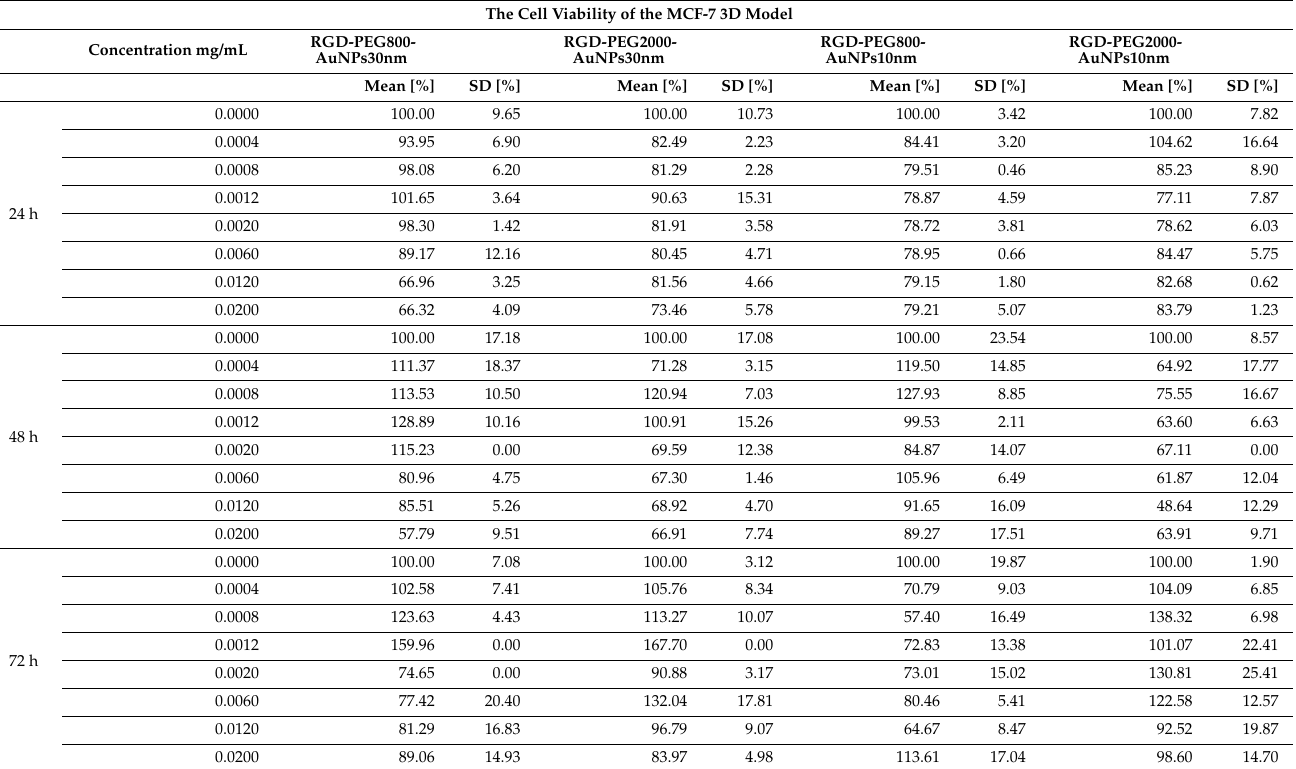
Table 2. The resume of the viability level of the MCF-7 3D model after incubation with AuNPs. In this test, RGD-PEG 800 -AuNPs 10nm and RGD-PEG 2000 -AuNPs 10nm , RGD-PEG 800 -AuNPs 30nm and RGD-PEG 2000 -AuNPs 30nm were used in concentrations of 0.0004, 0.0008, 0.0012, 0.0020, 0.0060, 0.0120 and 0.0200 mg/mL. Abbreviations: SD—Standard